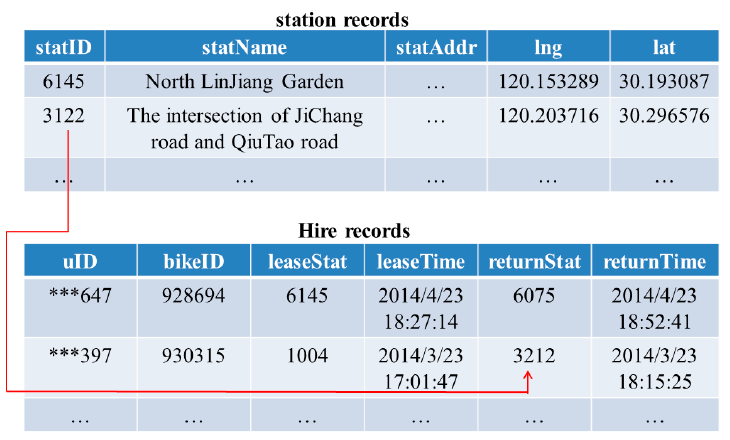
Figure 2. The station records and hire